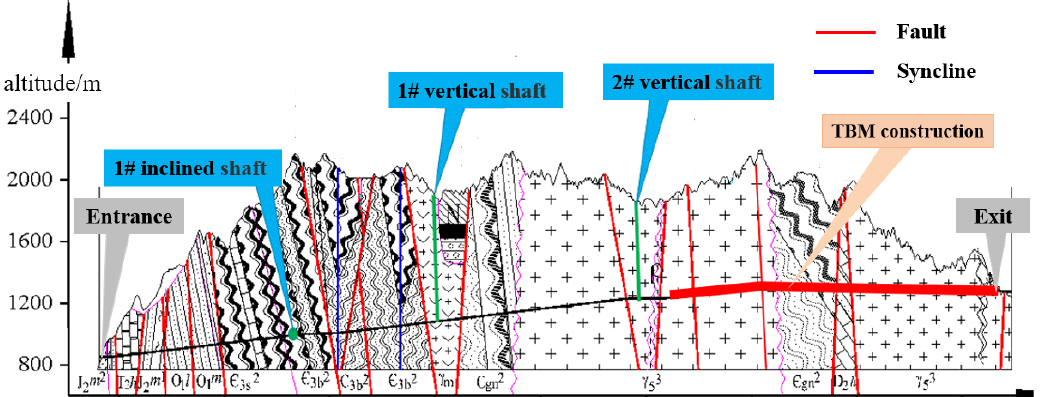
Figure 2. Strata section of No. 1 vertical shaft.